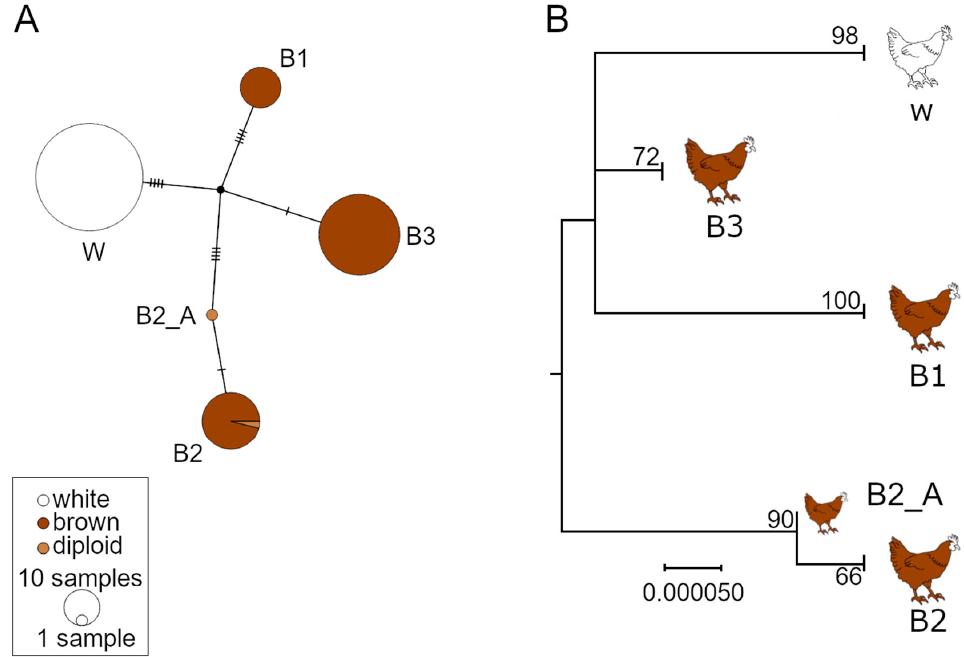
Figure 2. Evolutionary relationship of the mitochondrial genome of laying hens. ( A ) Haplotype network (TCS algorithm) and ( B ) maximum likelihood tree based on the mitochondrial genome (16,784 bp) of 180 laying hens. The tree is based on Hasegawa–Kishino–Yano model with 500 bootstrap replicates and includes all sites.